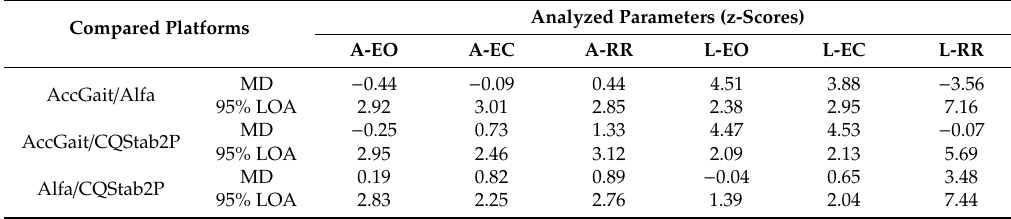
Table 5. Results from the Bland-Altman analysis of agreement between standardized values (z-scores) obtained from the platforms for all of the analyzed parameters Analyzed Parameters (z-Scores) Compared Platforms A-EO A-EC A-RR L-EO L-EC L-RR − 0.44 − 0.09 − 3.56 MD 0.44 4.51 3.88 AccGait / Alfa 95% LOA 2.92 3.01 2.85 2.38 2.95 7.16 − 0.25 MD 0.73 1.33 AccGait / CQStab2P 95% LOA 2.95 2.46 3.12 MD 0.19 0.82 0.89 3.48 Alfa / CQStab2P 95% LOA 2.83 2.25 2.76 1.39 7.44 A-EO: center of pressure area (mm2) with eyes open. A-EC: center of pressure area (mm2) with eyes closed. A-RR: center of pressure area (mm2) Romberg ratio. L-EO: center of pressure path length (mm) with eyes open. L-EC: center of pressure path length (mm) with eyes closed. L-RR: center of pressure path length (mm) Romberg ratio. MD: mean di ff erence between z-scores from the compared platforms. 95% LOA: limits of agreement, this value can be added to or subtracted from MD to obtain the upper and lower limits,